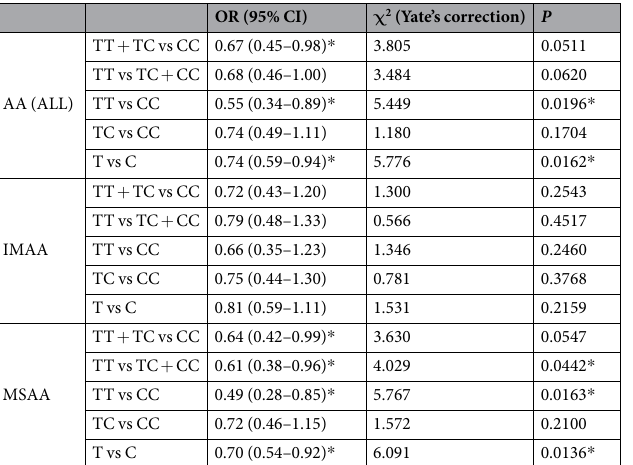
Table 4. Association between CD14 ( − 159 C/T) SNP and allergic asthma risk. AA, allergic asthmatics; CI, confidence interval; IMAA, intermittent-mild allergic asthmatics; MSAA, moderate-severe allergic asthmatics; OR, odds ratio; TC vs CC, heterozygote; TT vs CC, homozygote; TT vs TC + CC, recessive model; TT + TC vs CC, dominant model. * Significant